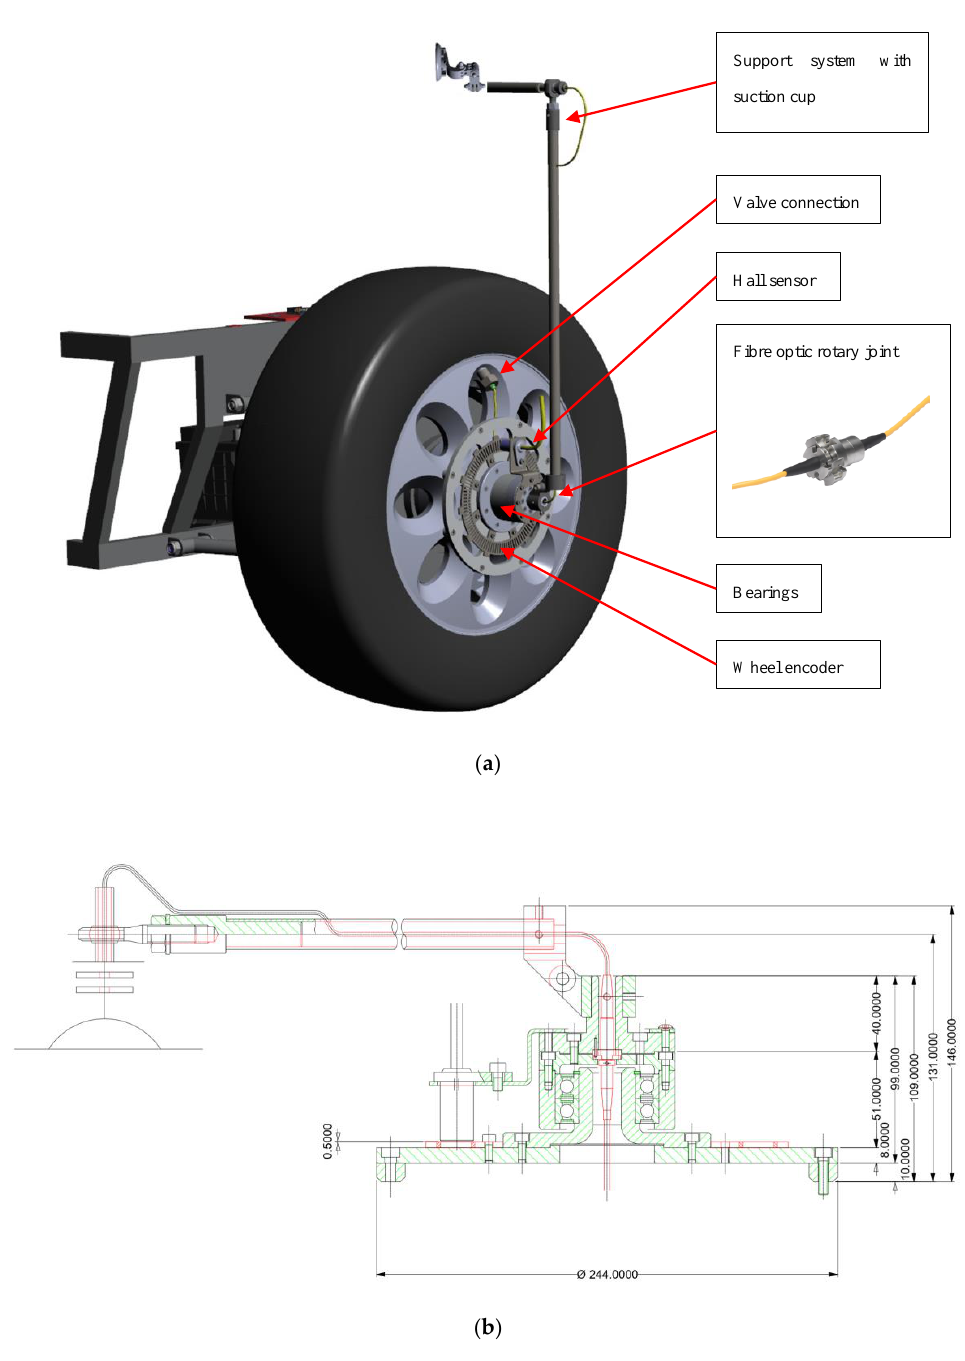
Figure 3. ( a ) The final assembly CAD of the wheel sensor device; ( b ) the side view CAD of the wheel sensor device with the FBG rotary coupler.